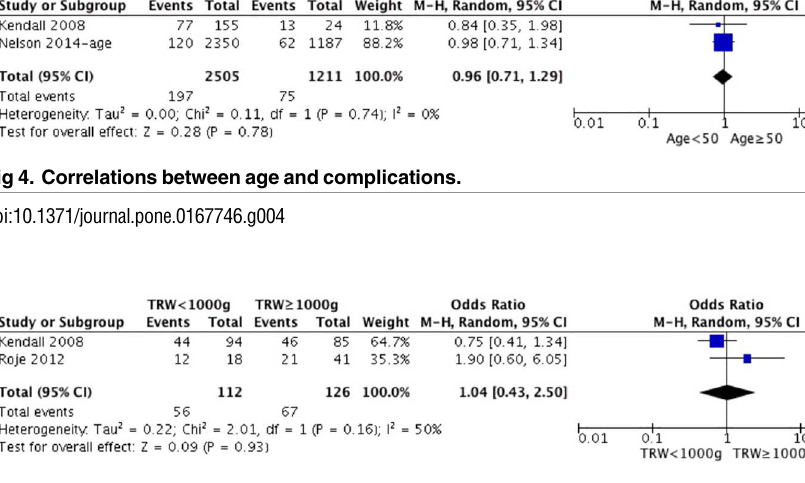
Fig 5. Correlations between tissue resection weight per breast and complications.